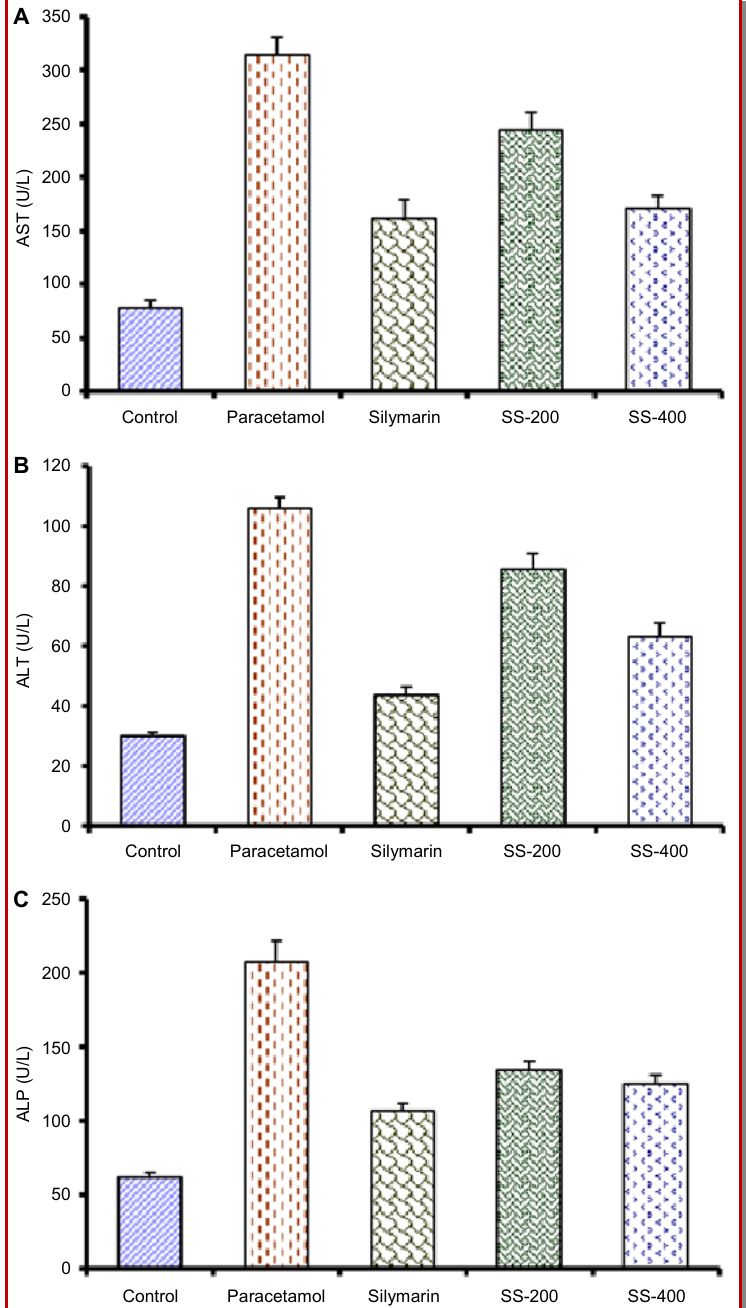
Figure 1: Effect of the methanolic extract of aerial parts of Sapium sebiferum on AST (A), ALT (B) and ALP (C). SS-200; 200 mg/kg of S. sebiferum , SS-400; 400 mg/kg of S.